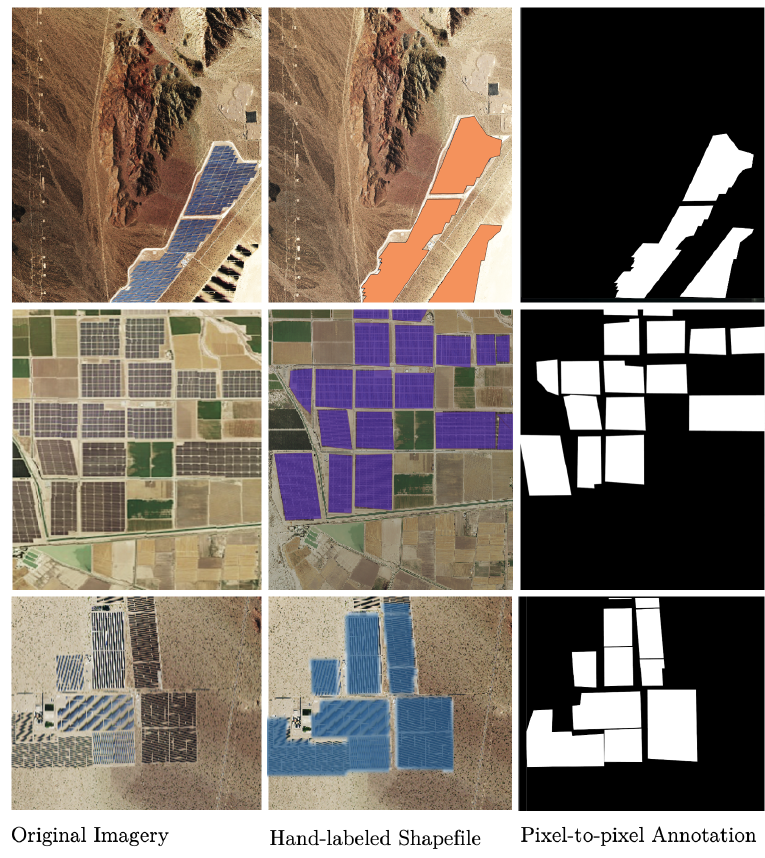
Figure 3. The dataset annotation